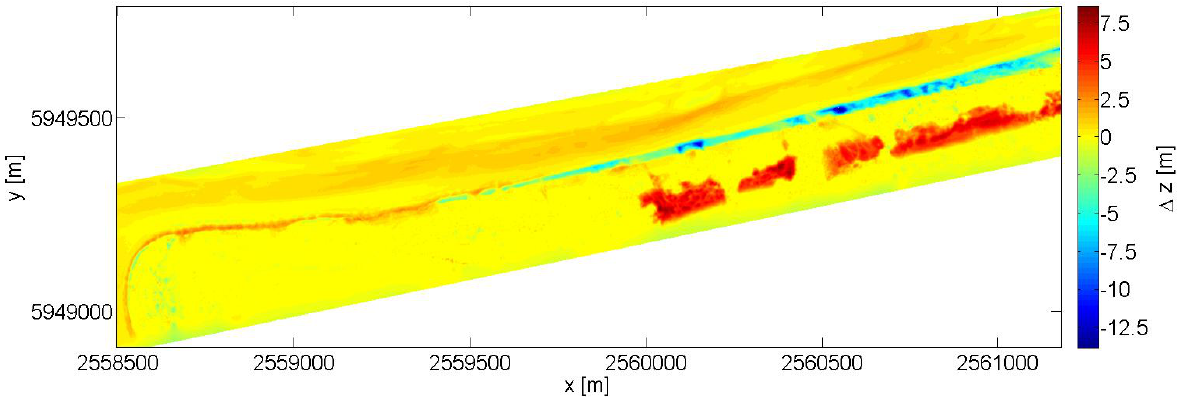
Figure 2. Differences between DTM 2010 and 2004 at the northern border of